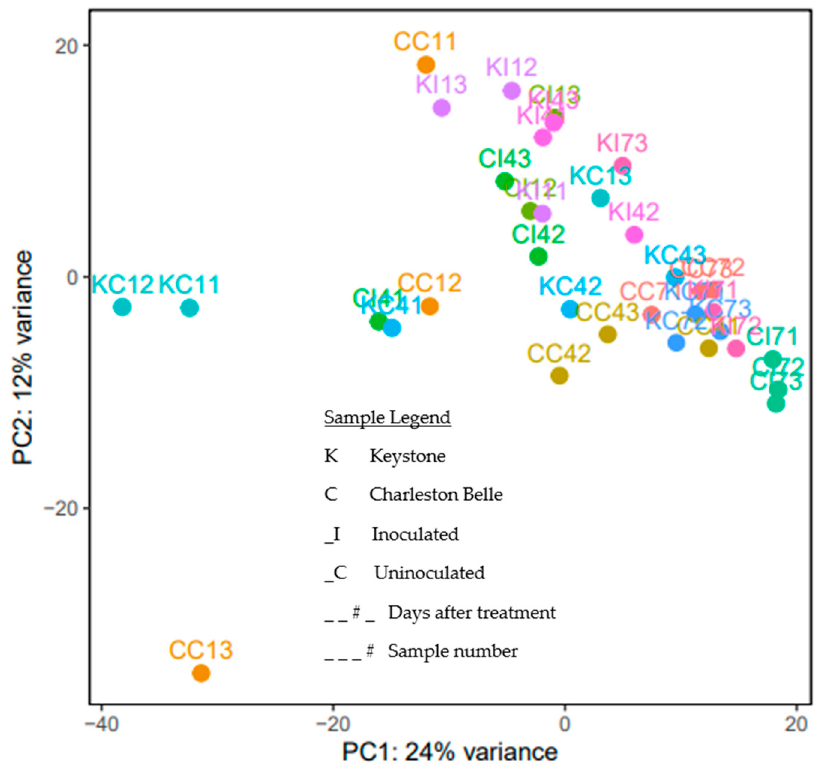
Figure 1. Principle component analysis of all samples by treatment shows general clustering of samples with a few outliers, Colors denote different cultivar and nematode treatments within the same timepoint.